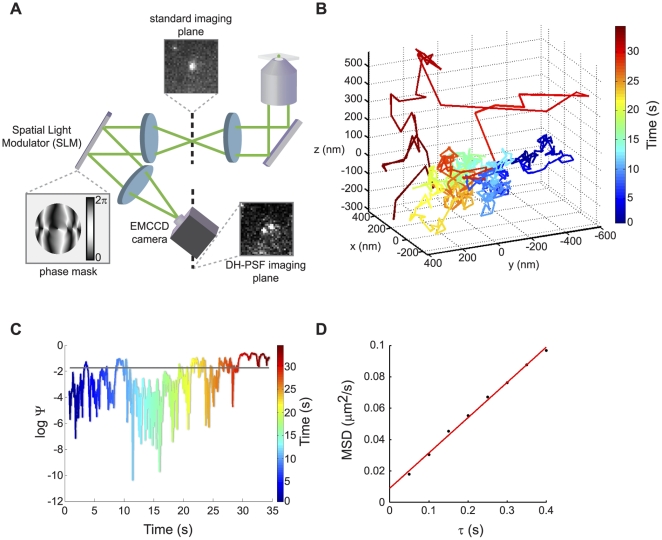
3D super-localization of mRNA particle dynamics using a DH-PSF setup.(A) Schematic of the DH-PSF setup using a spatial light modulator (SLM) exhibiting a phase mask [110] that produces the double-helix point spread function in the imaging plane (EMCCD camera). A single, diffraction-limited point of light shown in the standard imaging plane is detected as two spots in the DH-PSF imaging plane with z-position encoded in the angle between the two lobes. (B) 3D super-localization trajectory of a single BBC1:MS2 particle at 50 ms temporal resolution. Time is encoded by color as displayed in the heatmap. (C) Plot of log Ψ, a measure of the probability that a particle is confined during a portion of the trajectory, for the particle trajectory from panel (B) with time encoded by color. Portions of the trajectory falling below the 95% confidence threshold (dark grey line) are confined. (D) Mean-squared displacement (MSD) plot of the portion of the trajectory in B and C from 29.25 s to 34.45 s, plotted versus time for short time lags.